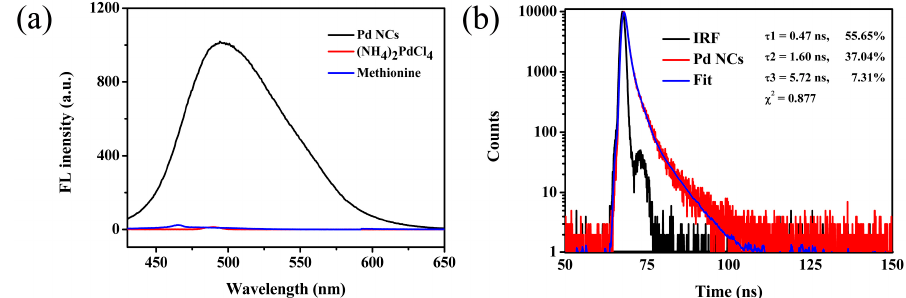
Figure 3. ( a ) Fluorescence spectra of prepared Pd NCs, (NH 4 ) 2 PdCl 4 and methionine solution; ( b ) Fluorescence lifetimes of Pd NCs in aqueous solution.